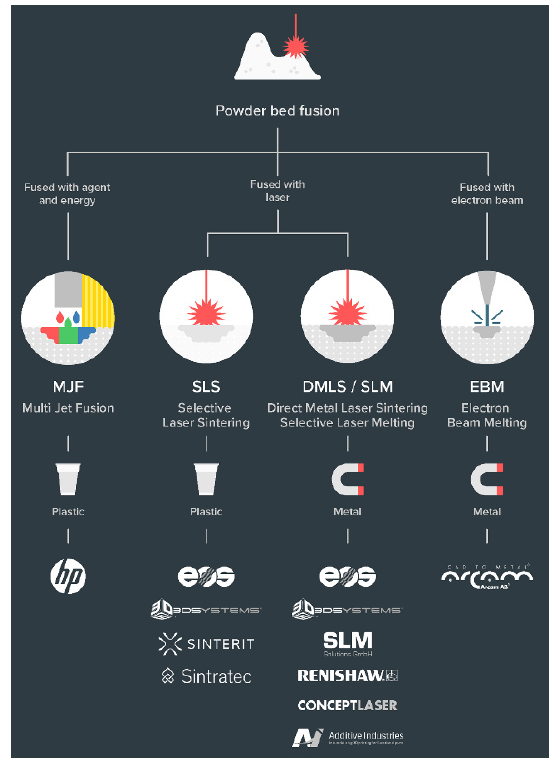
Figure 7. Powder bed fusion technologies [67].